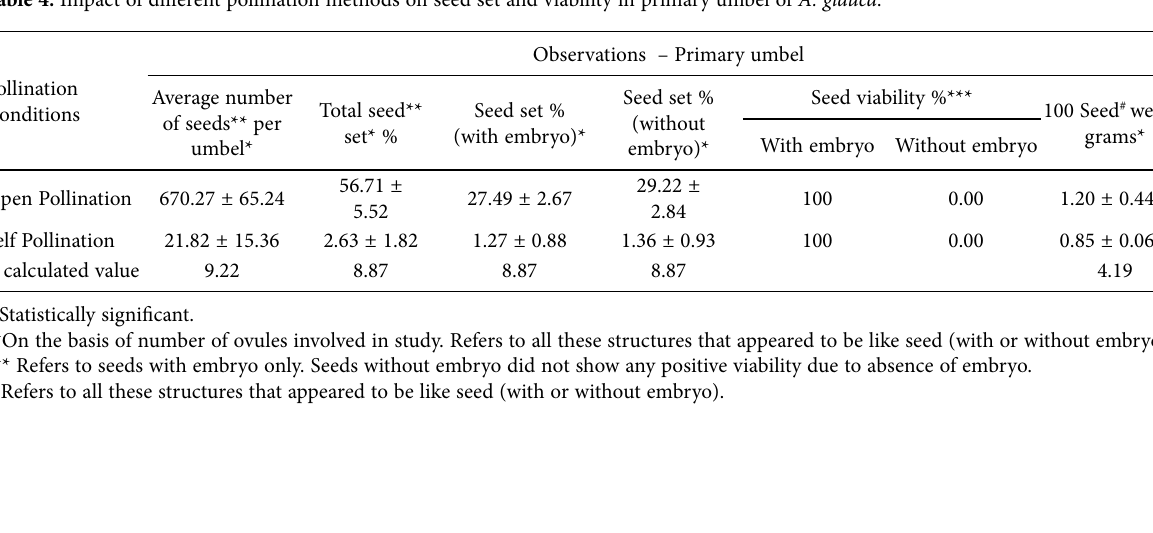
Table 4. Impact of different pollination methods on seed set and viability in primary umbel of A. glauca